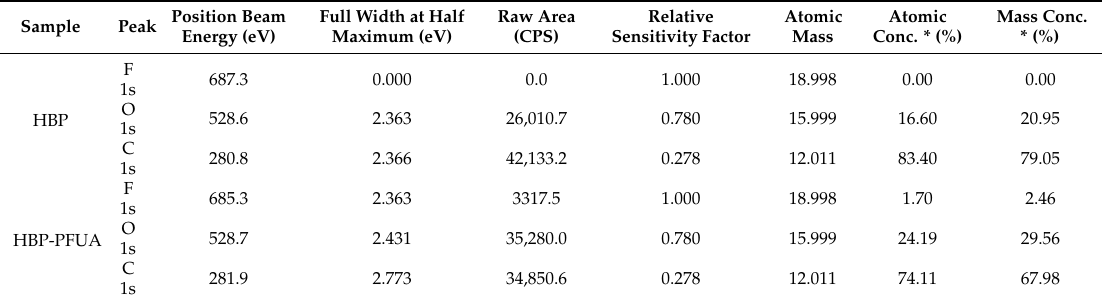
Table 1. XPS analysis of the surface of HBP and HBP + 1.2 wt. % of PFUA with 30 min of air exposure.